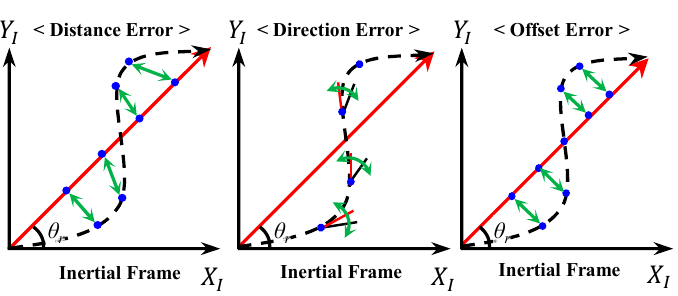
Figure 9. Definitions of the distance, direction and offset error for the maneuverability evaluation.